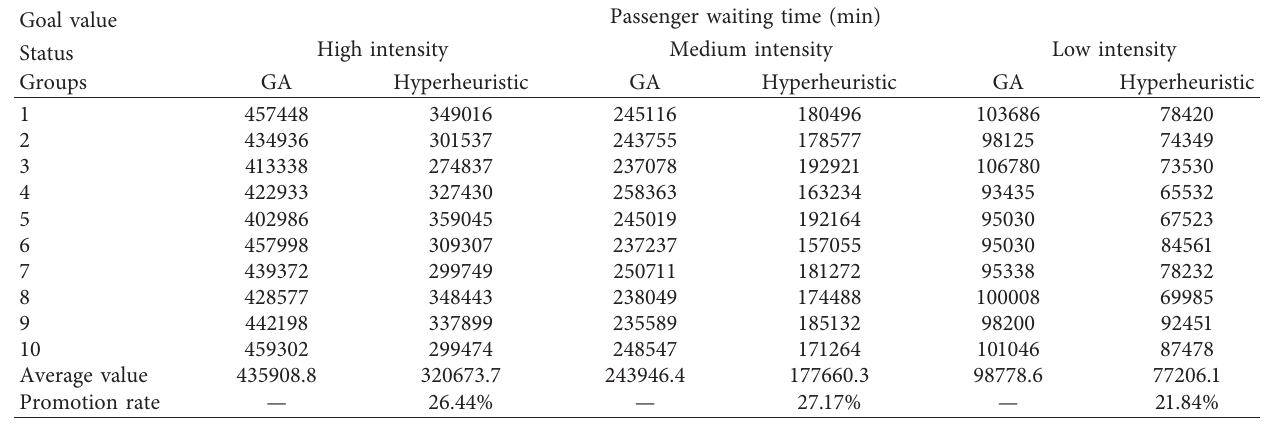
Table 3: Results of GA and hyperheuristic algorithm under increasing passenger flow.